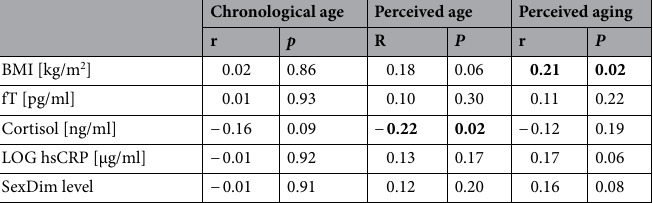
Table 5. Correlation between chronological age, perceived age, and aging and controlled variables in men (N = 116). Significant values are in bold.